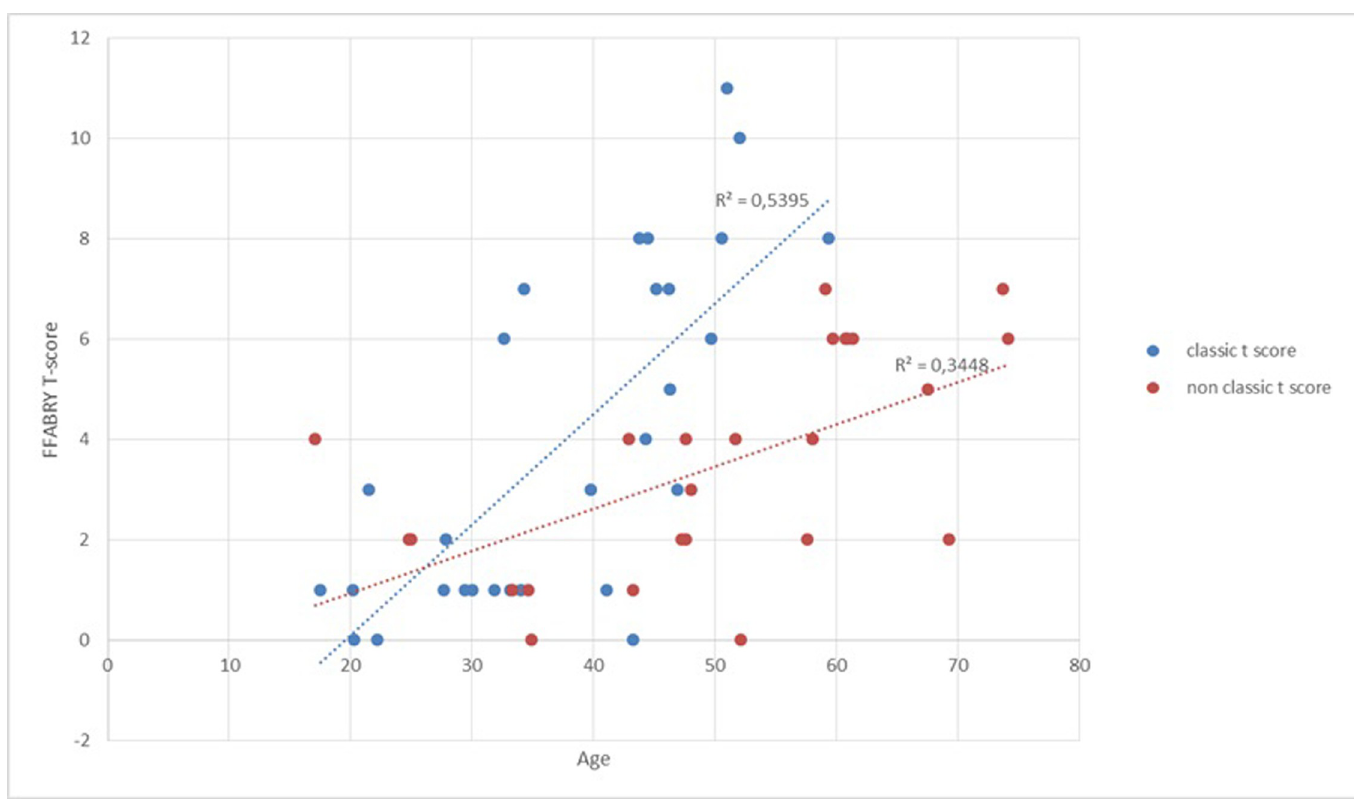
Fig 5. T-score evolution in the classical group compared to the nonclassical group (with associated linear regression curve).